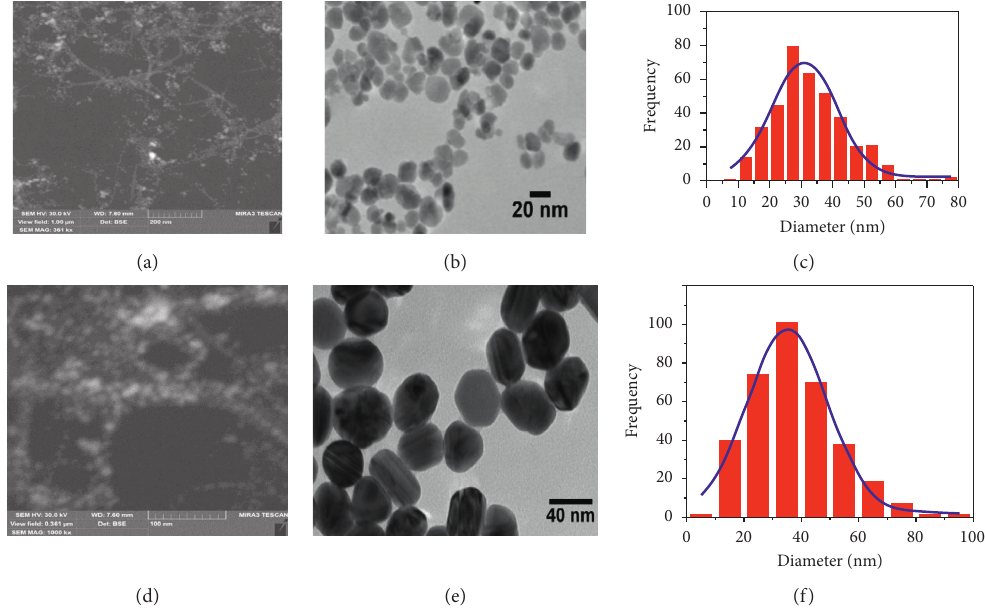
Figure 4: SEM and TEM images of silver nanoparticles obtained by plasma treatment in the presence of PVA and corresponding size distribution of AgNPs (C AgNO 3 0.3 and 1.0mmol/L, τ �